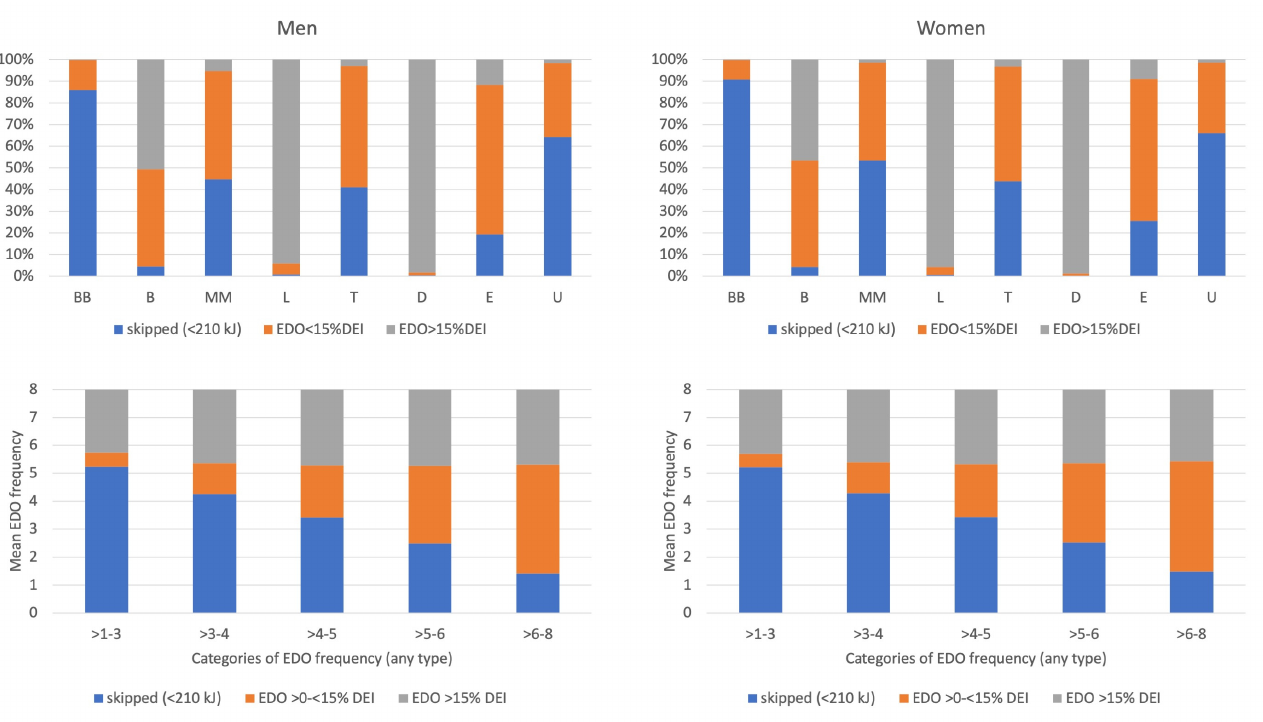
Figure A1. EDO Size and EDO Skipping by Recording Section ( top ) and by EDO Frequency ( bottom ).